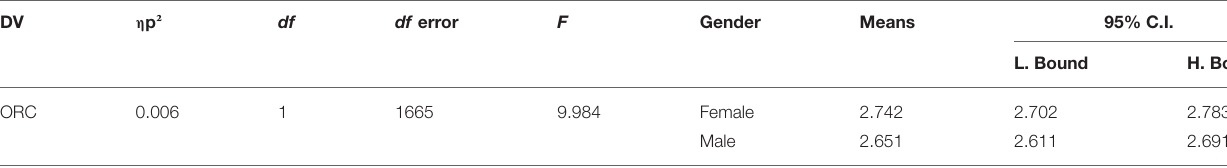
TABLE 3 | Significant univariate effects for gender (significant at p < 0.001).